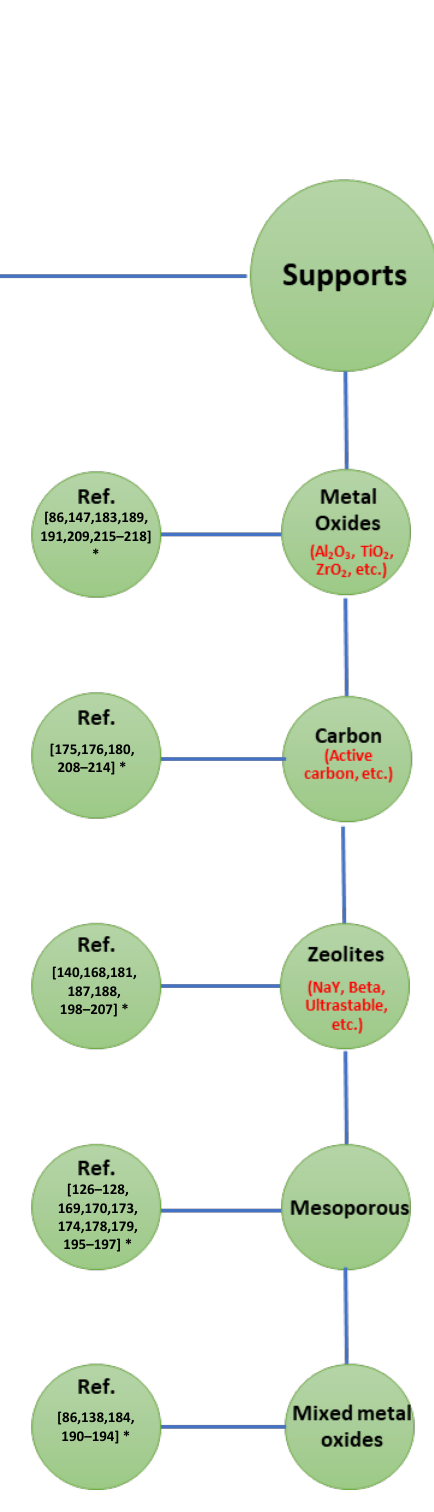
Figure 3. Summary of principal supports and active metals used for green diesel production via DO process by heterogeneous catalysis. For each listed active phase and support type, numbers in the connected “Ref.” spaces correspond to related literature references listed with the same numbers in the References Section at the end of this manuscript